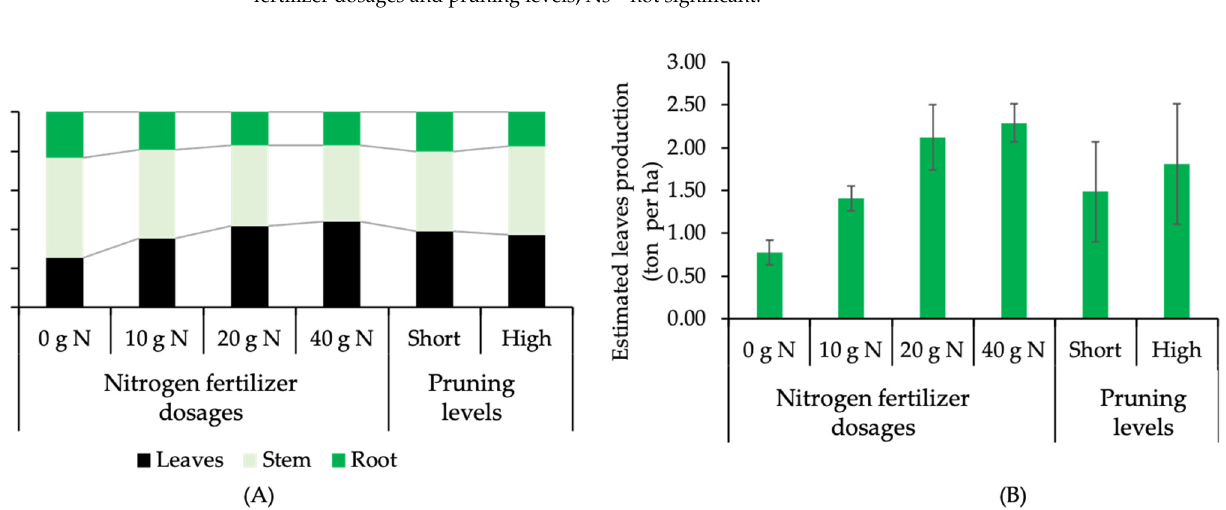
Figure 3. Regression curve of kaffir lime ( A ) fresh weight of leaves and ( B ) leaf numbers under different nitrogen-fertilizer dosages. Note: mean values followed by the same letter within the same curve are not significantly different based on DMRT at α 0.05. 2.4. Physiological Response of Kaffir Lime under Different Pruning Levels and N Dosages The alteration of growth and production of kaffir lime in response to different N- fertilizer dosages and pruning levels was followed by the variable of plant physiology. Higher leaf production in N-fertilized plants was associated with an increase in the rate of plant photosynthesis. The rate of photosynthesis between plants fertilized with 20 g N and 40 g of N was insignificant; however, there was a noticeable increase of about 15% compared to both control (0 g N) and 10 g N (Table 4). In contrast, there was no significant difference in N-fertilizer dosage on stomatal conductance, transpiration rate, stomatal lim- itation to CO 2 uptake, and water-use efficiency (WUE) in the kaffir lime plants. Stomatal conductance, transpiration rates, intrinsic WUE and instantaneous LUE in the present ex- periment varied in the range of 0.37–0.38 mol H 2 O m − 2 s − 1 , 6.25–6.59 mmol H 2 O m − 2 s − 1 , 2.68–3.23 μ mol CO 2 mmol H 2 O − 1 , and 0.58–0.98 μ g lux − 1 , respectively.